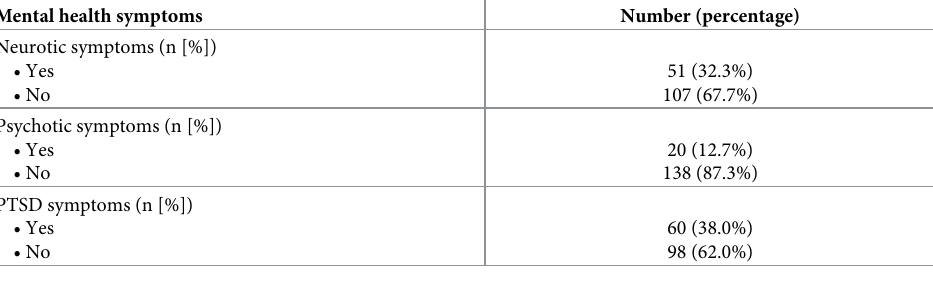
SARS-CoV-2 is presumed to affect female fertility through its interaction with angiotensin- converting enzyme 2 (ACE2) [24]. ACE2 is highly expressed in the ovaries, regulating follicu- lar development and ovulation and luteal angiogenesis and affecting regular changes in endo- metrial tissue. Thus, ACE2 plays a significant role in female reproduction [25]. SARS-CoV-2 may affect female fertility by damaging ovarian tissue and granulosa cells [5]. Moreover, COVID-19 infection is usually accompanied by high levels of interleukin-6, interleukin-8, tumor necrosis factor- α , and other cytokines, which promote a procoagulation state that may affect fetal implantation and development [26]. Table 3. Mental health profiles based on SRQ-29